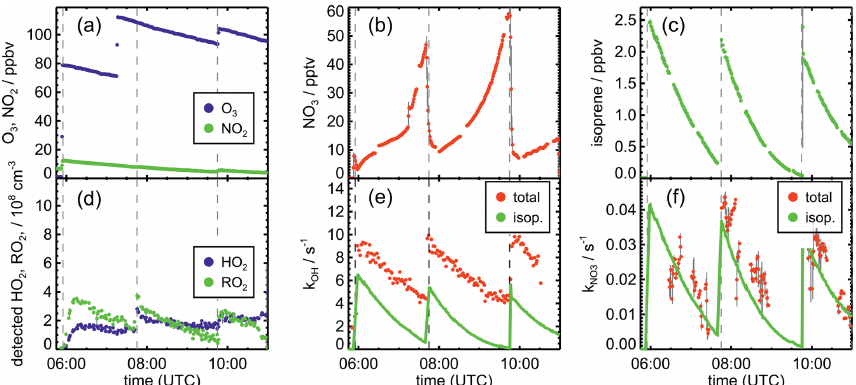
Figure 2. Measurements of radical and trace gas concentrations and OH and NO 3 reactivity in the experiment on 13 August 2018 (Exper- iment 4) investigating the oxidation of isoprene by NO 3 , when the total amount of oxidized isoprene was highest. OH and NO 3 reactivity from isoprene is calculated from measured isoprene concentrations and reaction rate constants recommended in the literature (Mellouki et al., 2021). NO 3 reactivity does not include reactivity from organic radicals and NO 2 . Observed RO 2 radicals only include a fraction of the total RO 2 because the LIF instrument cannot detect all RO 2 species formed in the reaction of isoprene with NO 3 (Vereecken et al.,